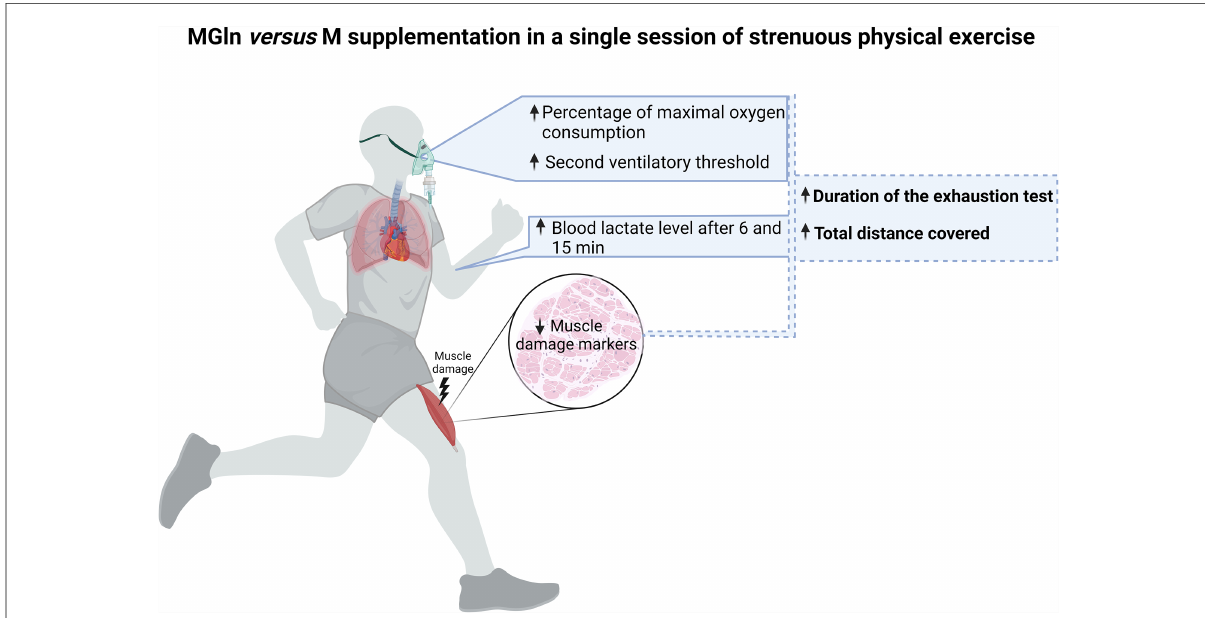
FIGURE 6 Graphical abstract – A single dose of MGln supplementation resulted in exercising at a higher percentage of maximal oxygen consumption, a higher second ventilatory threshold, blood lactate levels, and reductions in plasma markers of muscle damage (LDH, total CK and skeletal muscle CK). Created with